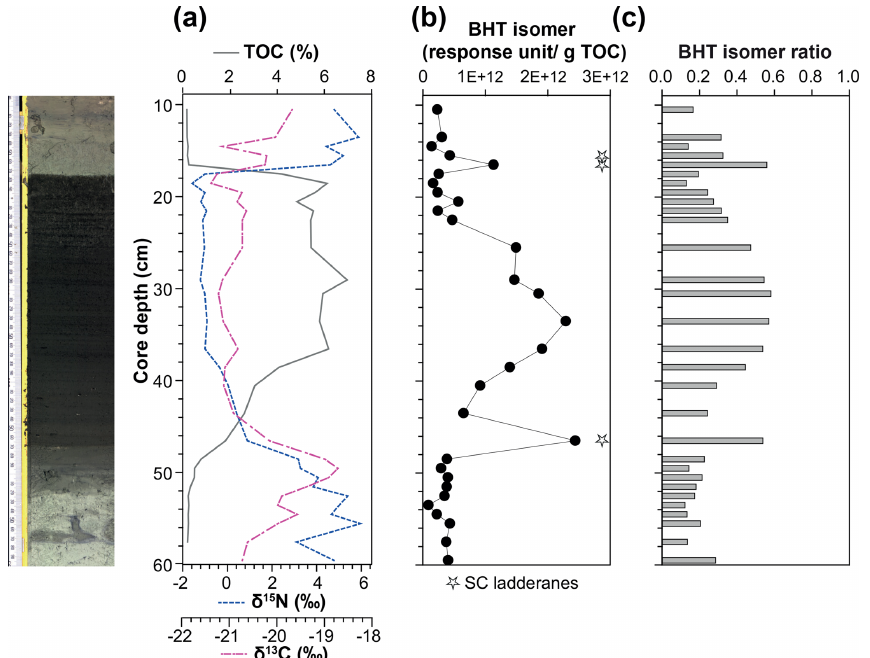
Figure 4. (a) Total organic carbon (TOC) content, isotope values of bulk nitrogen ( δ 15 N) and carbon ( δ 13 C), (b) BHT isomer concentration (circles) and presence of short-chain (SC) ladderane fatty acids (stars), and (c) BHT isomer ratio through a high-resolution S5 sapropel record from site 64PE406 (R/V Pelagia ) in the Levantine Basin. The sapropel is indicated by the darker sediment. Core photo provided by Rick